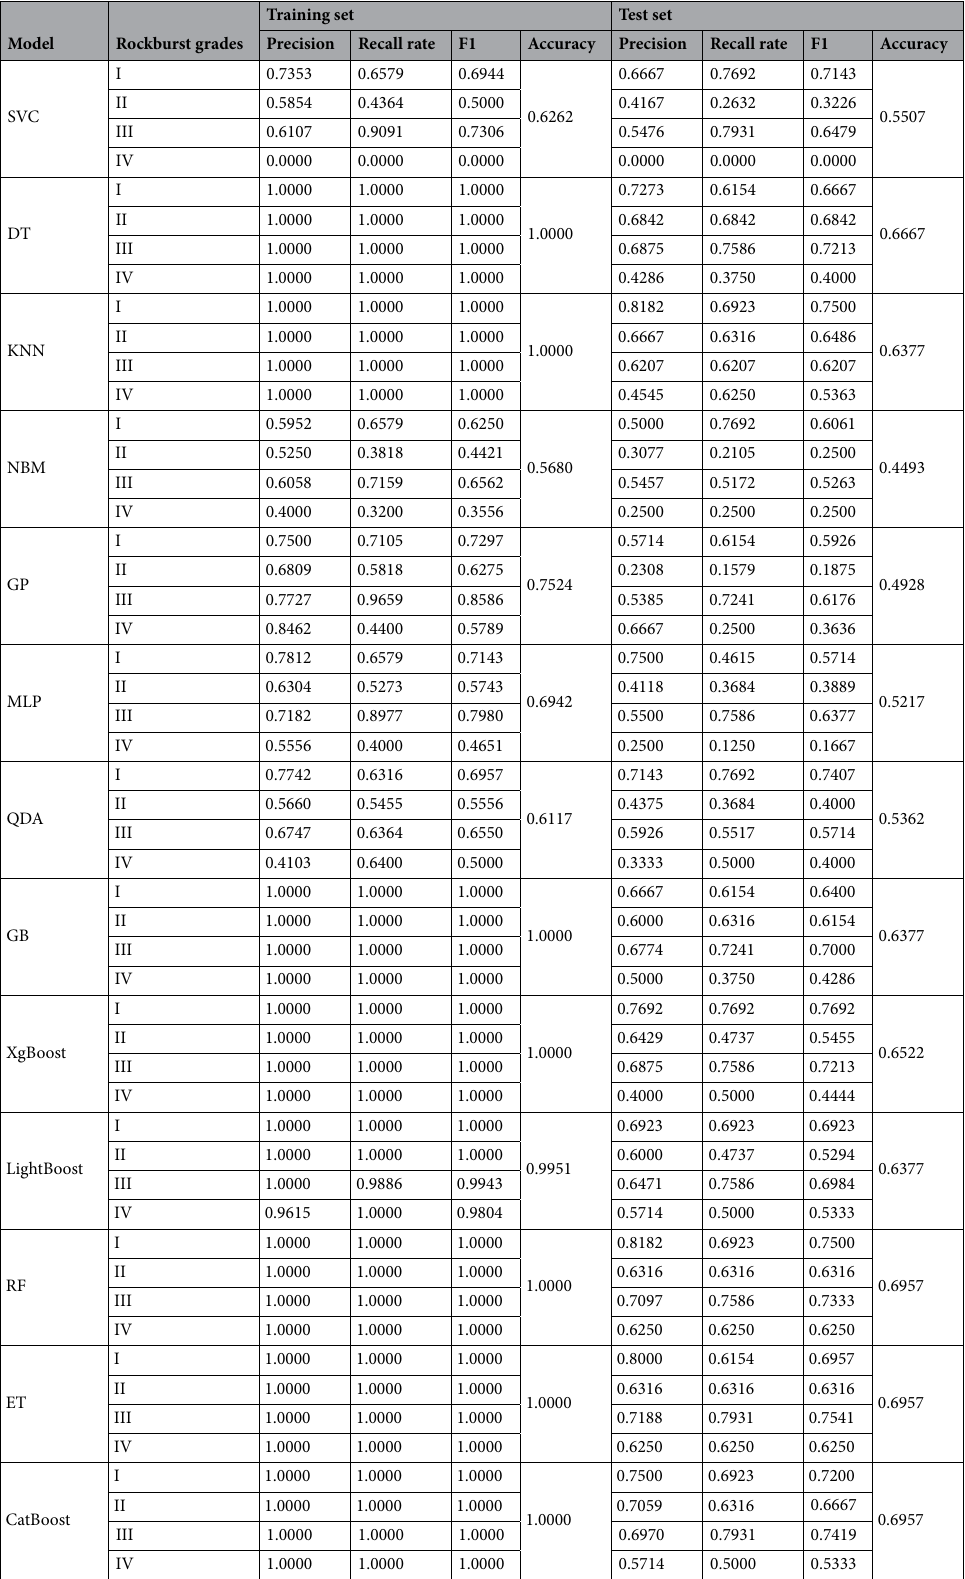
Table 3. Prediction results with the original rockburst